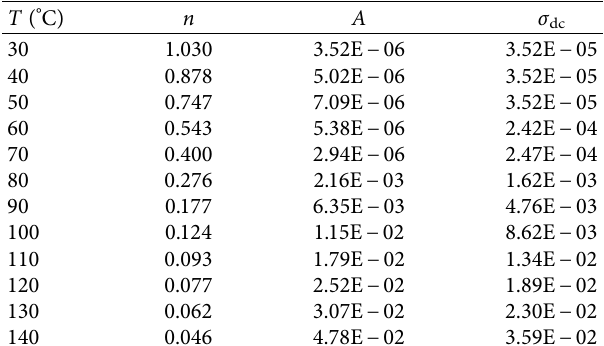
Table 4: Values of the exponent n , coefficient A , and the DC conductivity for pure 0.5 wt.% FeCl 2 PVA/PVP electrolyte blend sample.